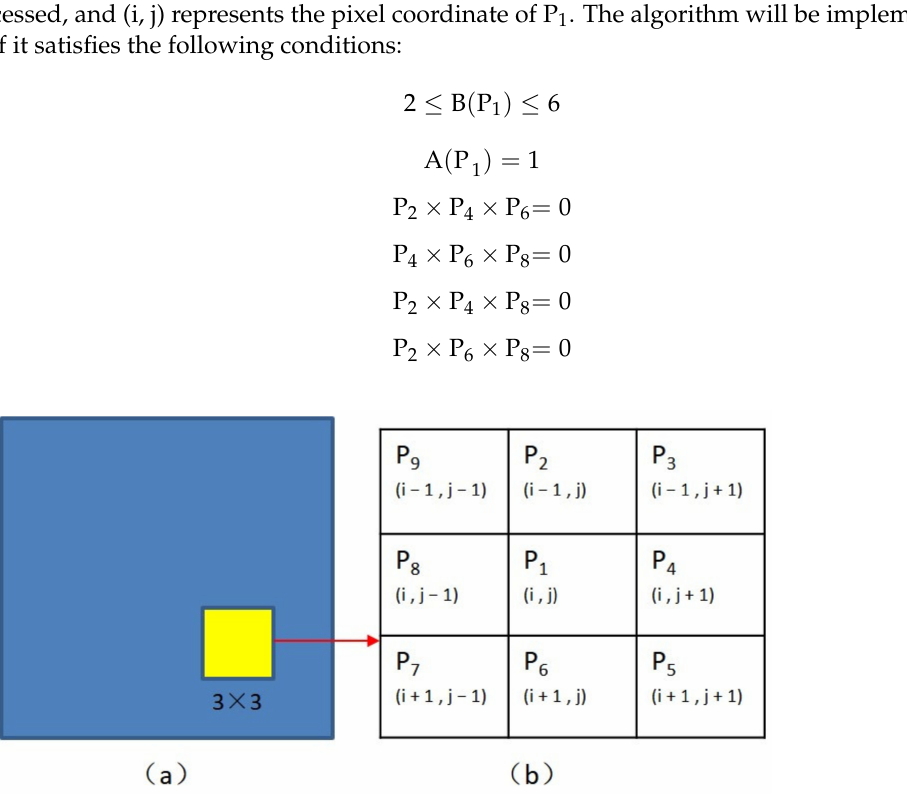
Figure 7. The naming of 9 pixels in 3 × 3 regions. ( a ) original image; ( b ) the naming of 9 pixels in 3 × 3 regions in the original